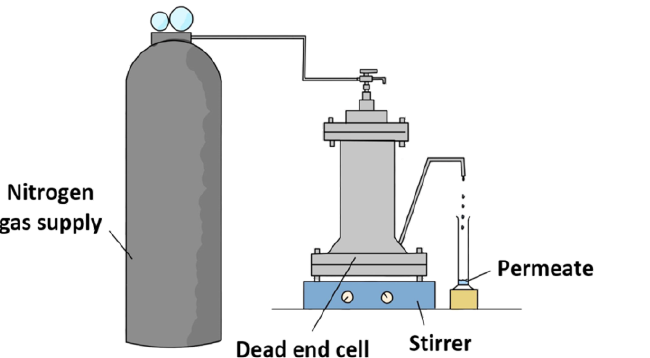
Figure 1. Schematic diagram of dead-end permeation cell setup for membrane evaluation. The water flux, J W (L/m 2 · h), and pure water permeability, PWP (L/m 2 · h · bar) of each membrane can be evaluated using Equations (1) and (2),